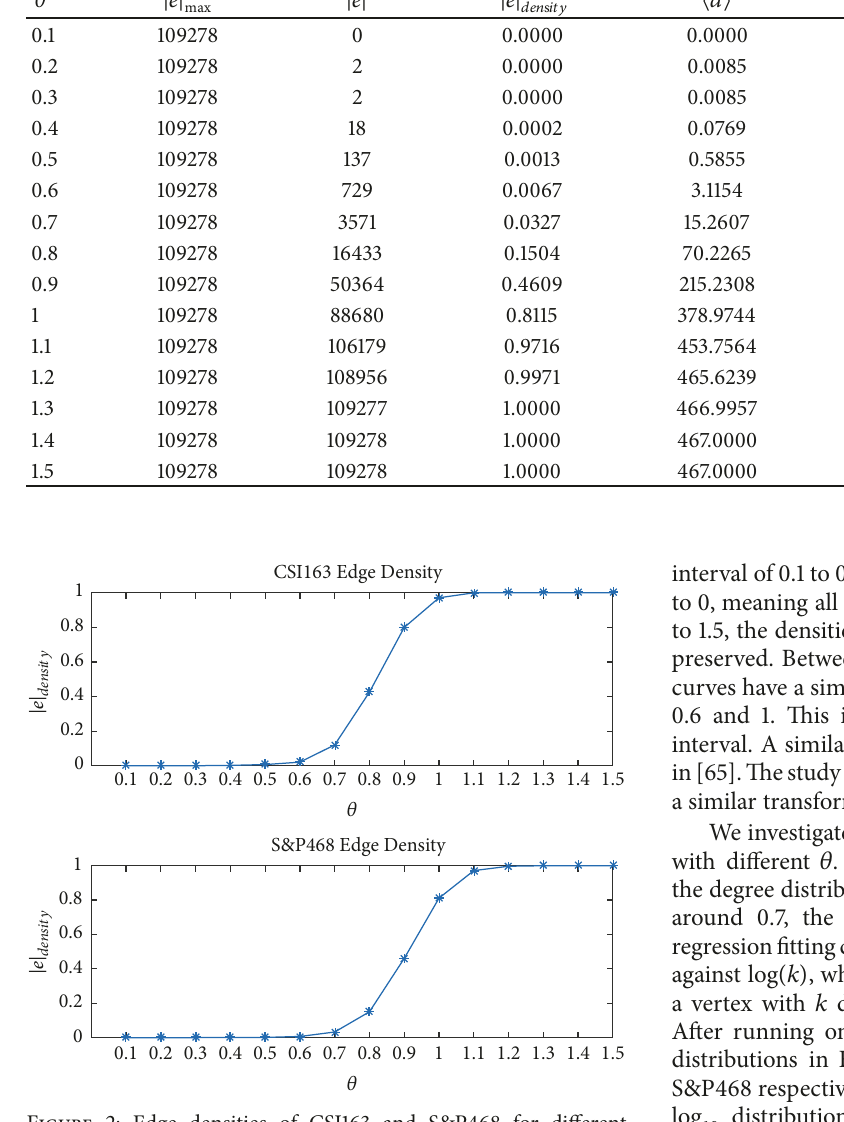
Figure 2: Edge densities of CSI163 and S&P468 for different thresholds 𝜃 from 0.1 to 1.5. It shows that the densities increase sharply from 0 to 1 in the 𝜃 interval of 0.6 and